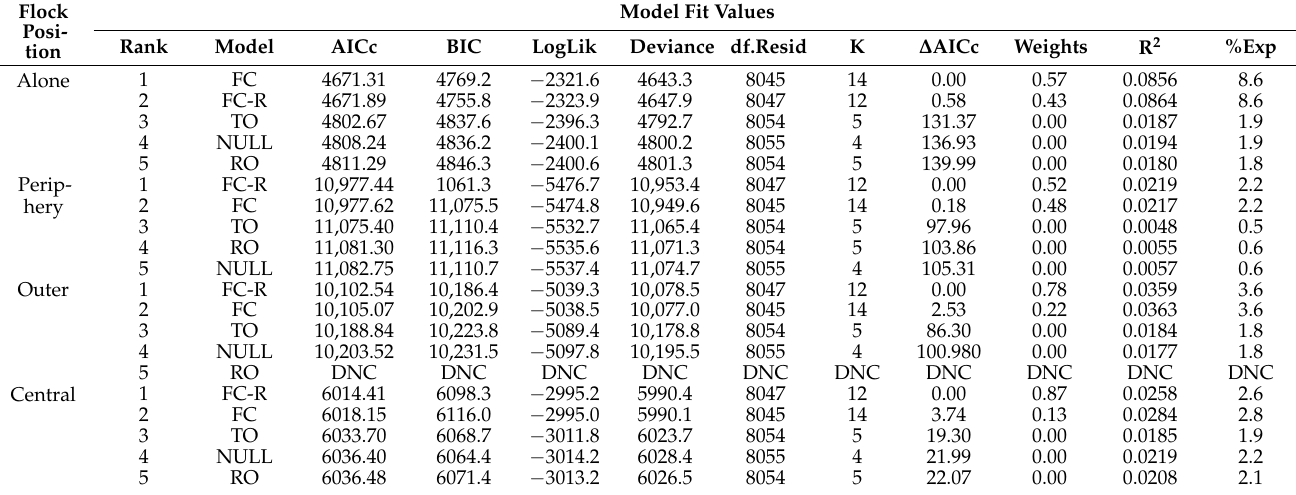
Table A5. Model fit values of binomial GLMMs explaining chicks occupancy in positions relative to their